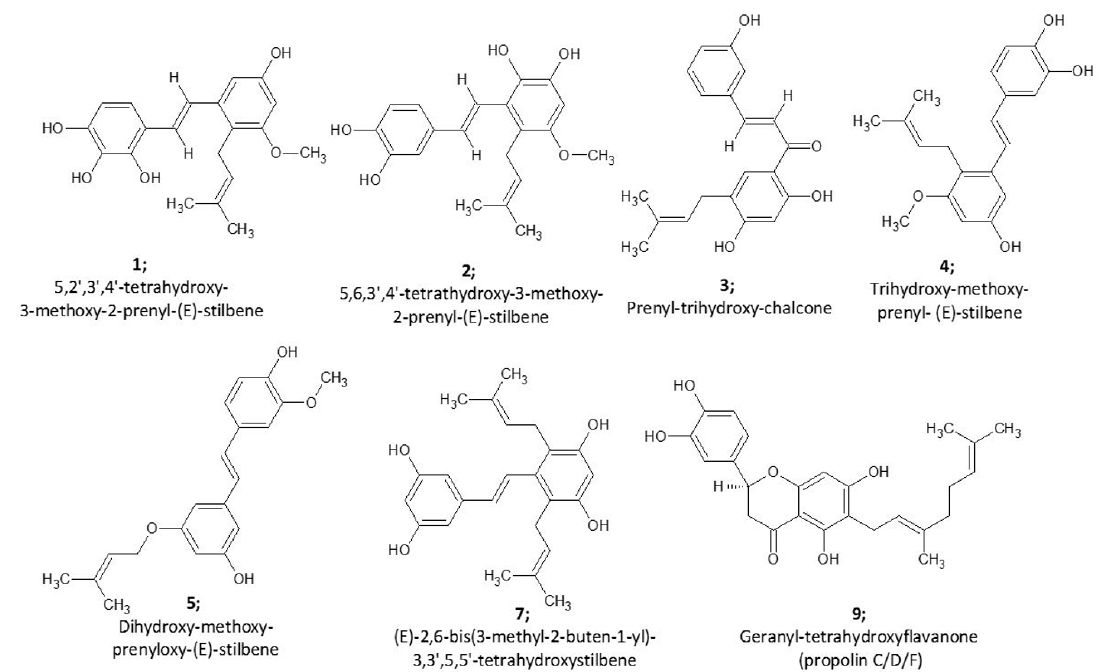
Figure 2. Putative LC-MS identified metabolites in the AP-1 extract with potential anticancer activity against the MCF7